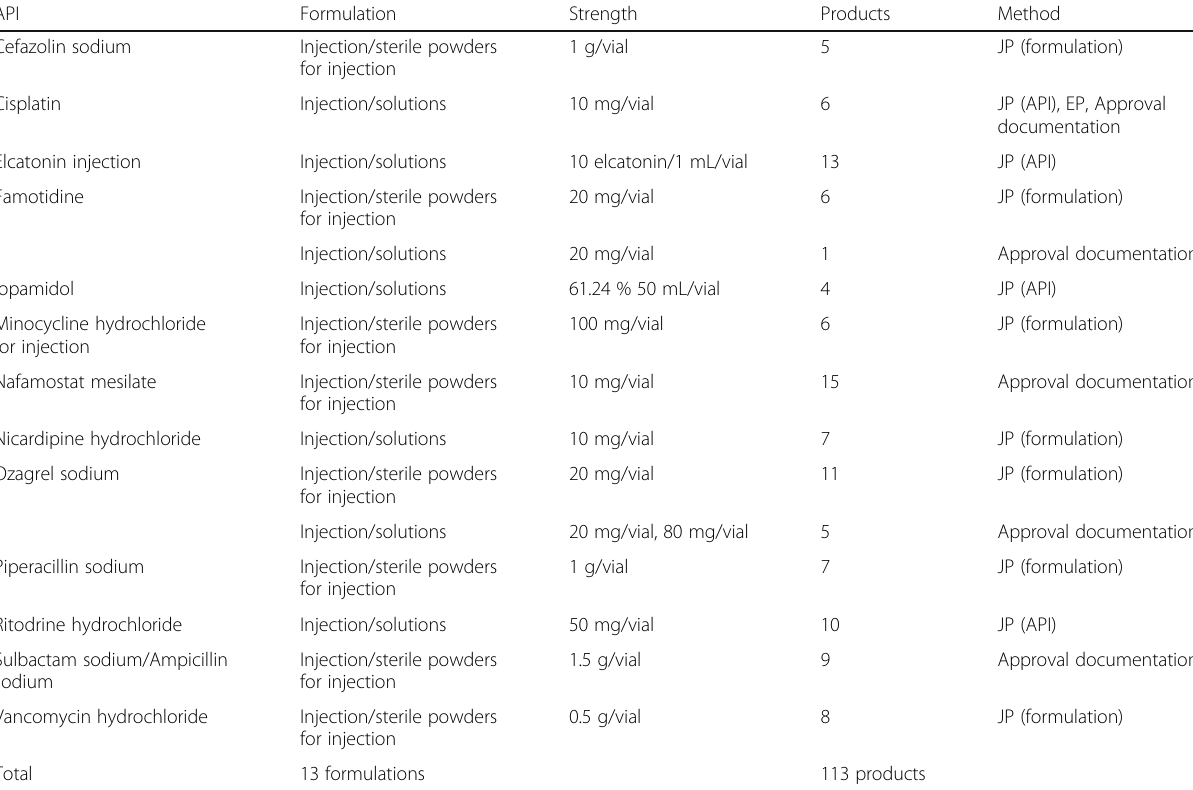
Table 4 Number of injections tested for purity by the Formulation